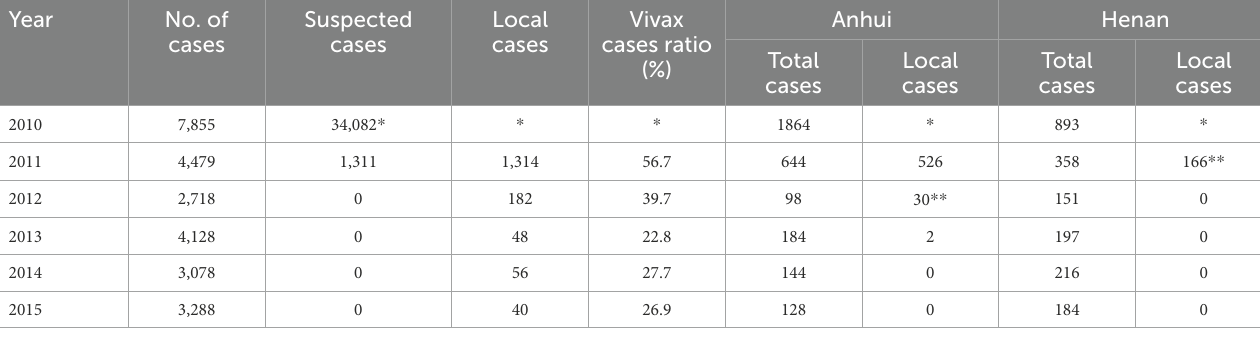
TABLE 1 Reported malaria cases in China (with Anhui and Henan province) from 2010 to